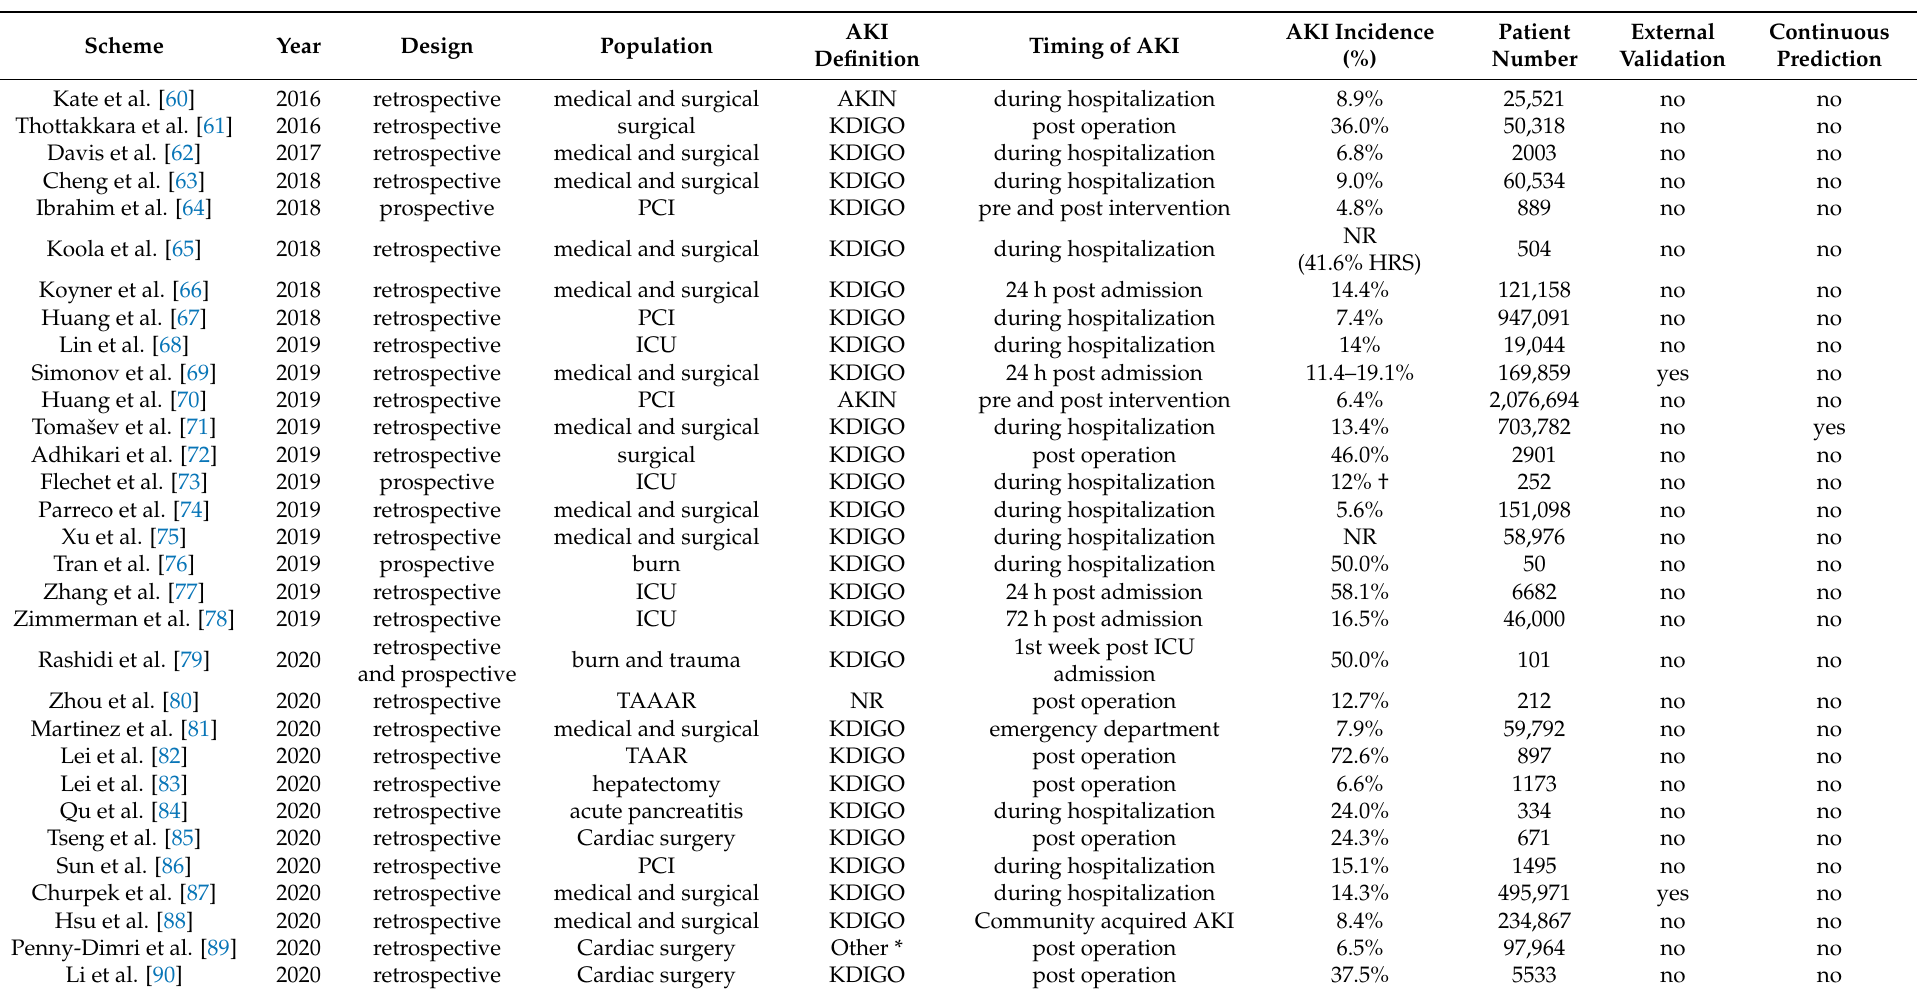
Table 1. Summary of machine-learning studies on acute kidney injury (AKI)